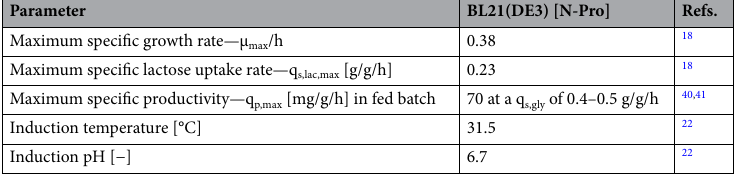
Table 1. Prior knowledge on the expression strain BL21(DE3) producing the N-Pro model protein.